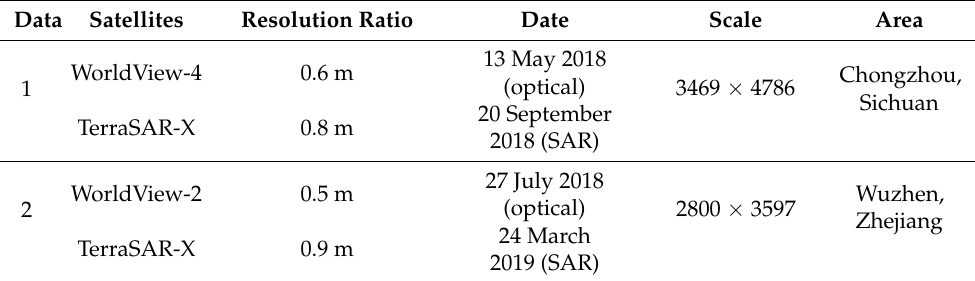
Table 2. Two sets of large-scale images used in decision-level fusion experiments.